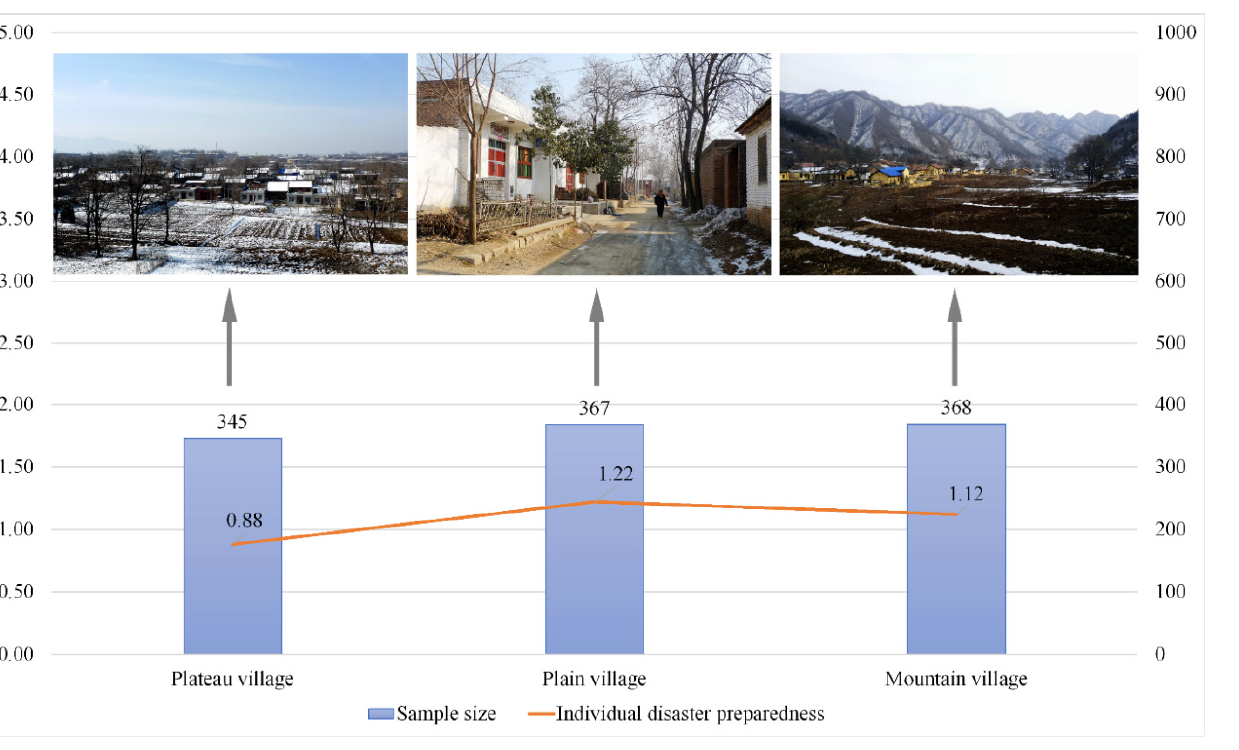
Figure 2. Level of self-reported individual and household disaster preparedness. Notes: (1) ANOVA test result of InDP among the three villages: F(2,1064) = 8.075, p < 0.001, with missing value = 13; (2) The photos were taken by the research team during the survey in February 2018.